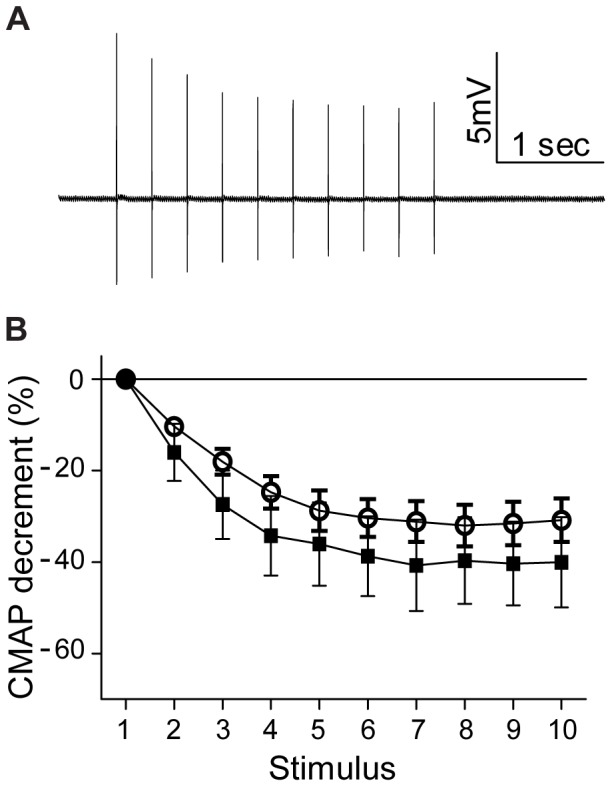
Albuterol treatment did not prevent neuromuscular failure in mice injected with anti-MuSK IgG.(A) A representative compound muscle action potential (CMAP) trace recorded from the gastrocnemius muscle of a mouse after 15 daily injections of anti-MuSK IgG. The amplitude is seen to decline during repetitive stimulation of the sciatic nerve (3 stimuli per second). (B) Average decrement in CMAP amplitude for myasthenic mice treated with either albuterol (8 mg/kg/day; filled squares) or vehicle (open circles) on day 15 the anti-MuSK IgG injection series. The mean amplitude of the first CMAP of the train was 9.6±2.7 mV for mice injected with anti-MuSK IgG and treated with albuterol compared to 13.5±2.1 mV for mice injected with anti-MuSK IgG and treated with vehicle (P>0.05). Data represent the mean ± SEM for n = 3–4 mice in each treatment group.